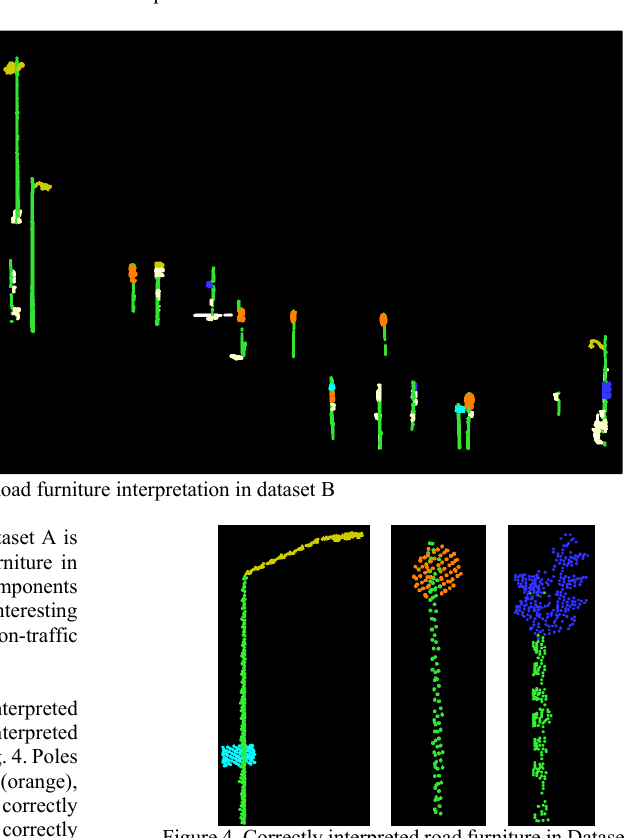
Figure 2. Road furniture interpretation of dataset A